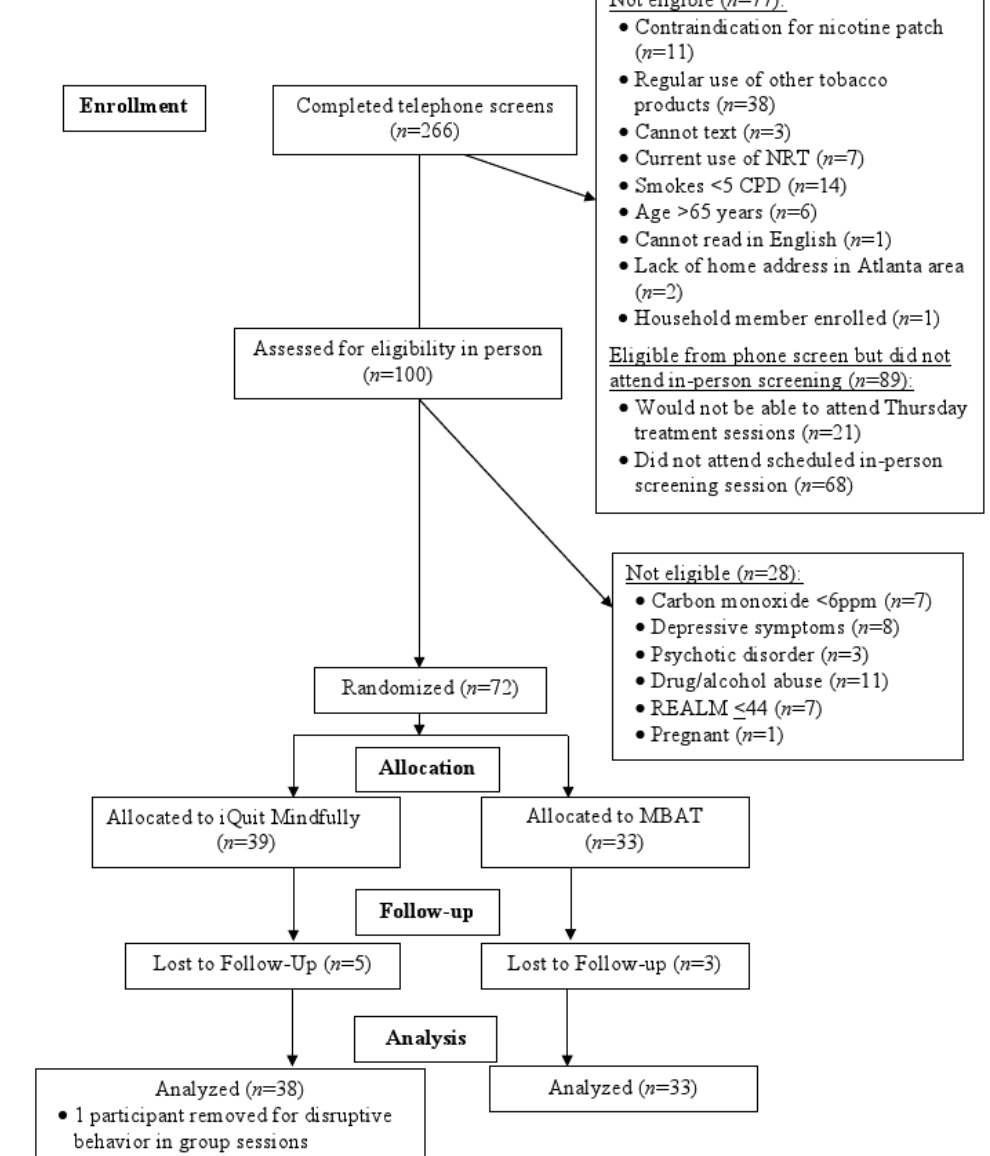
Figure 1. Consolidated Standards of Reporting Trials flow diagram. CPD: cigarettes per day; MBAT: Mindfulness-Based Addiction Treatment; NRT: nicotine replacement therapy; REALM: Rapid Estimate of Adult Literacy in